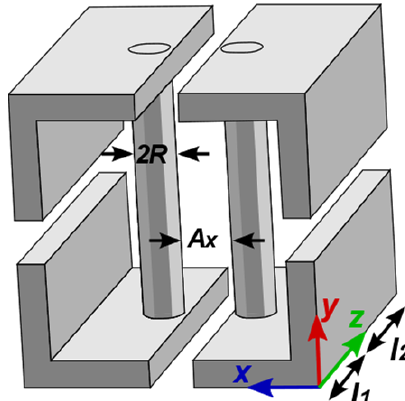
Figure 4. TEM unit-cell with loads.